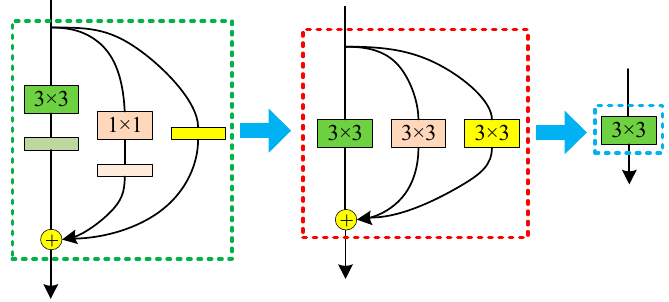
Figure 2. Schematic Diagram of Reparameterization.